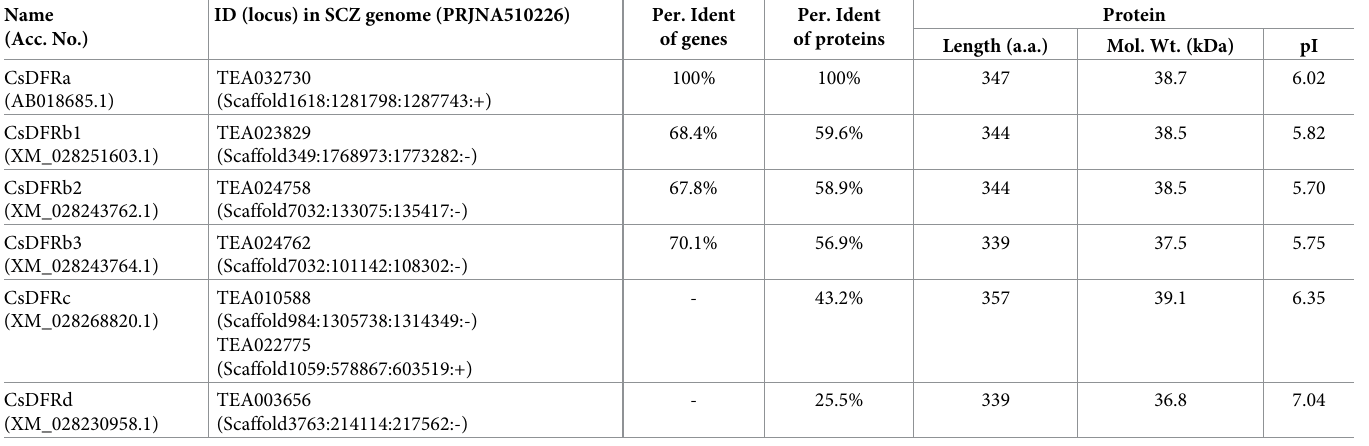
Table 1. Accession information for putative CsDFRs and predicted protein parameters. Name ID (locus) in SCZ genome (Acc. No.)